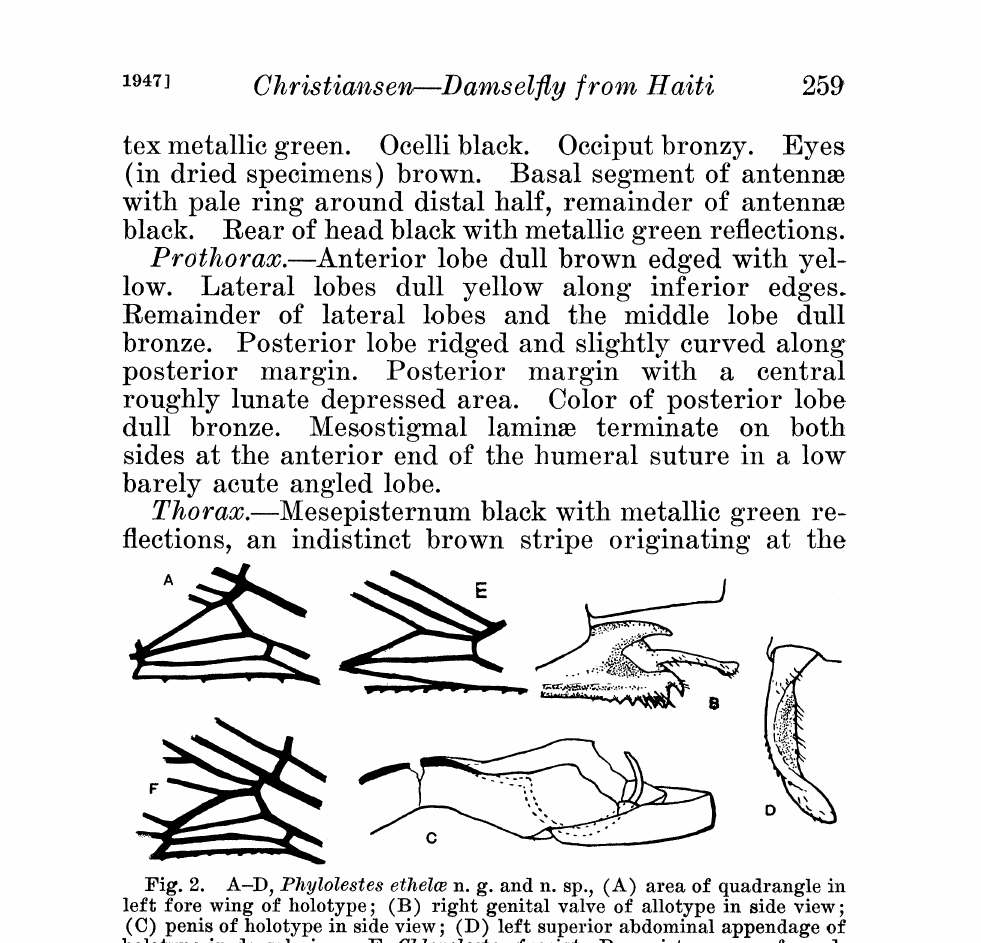
Fig. 2. A-D, Phylolestes ethele n. g. and n. sp., (A) area of quadrangle in left fore wing of holotype; (B) right genital valve of allotype in side view; (C) penis of holotype in side view; (D) left superior abdominal appendage of holotype in dorsal view. E, Chlorolestes fasciata Burmeister area of quad- rangle in left fore wing. F, Megalestes major Selys, area of quadrangle in left fore wing. All figures